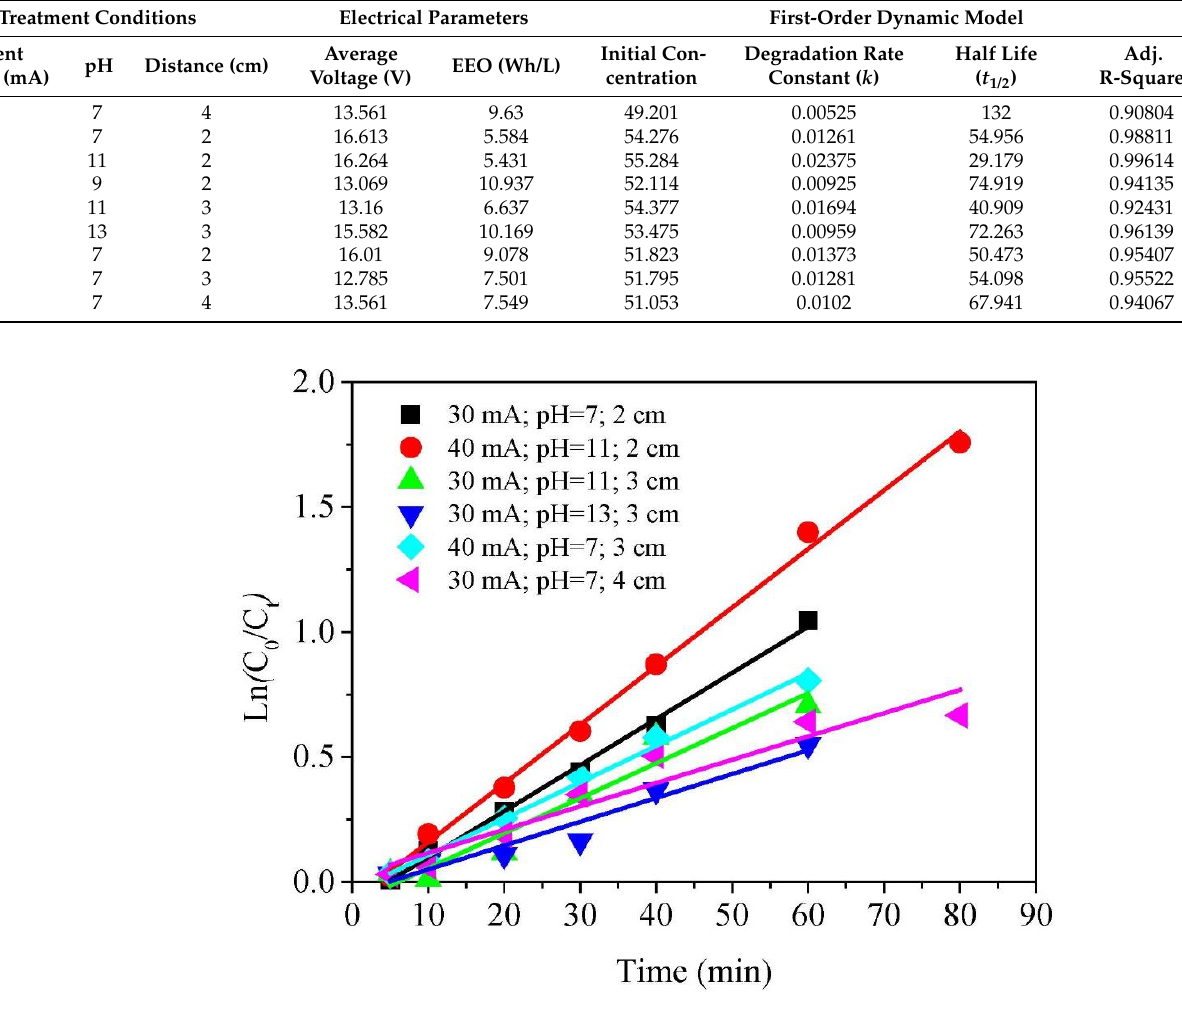
Figure 6. Electro-catalytic performance comparison of the various conditions by the PbO 2 -NF electrode in terms of kinetic analysis curves.